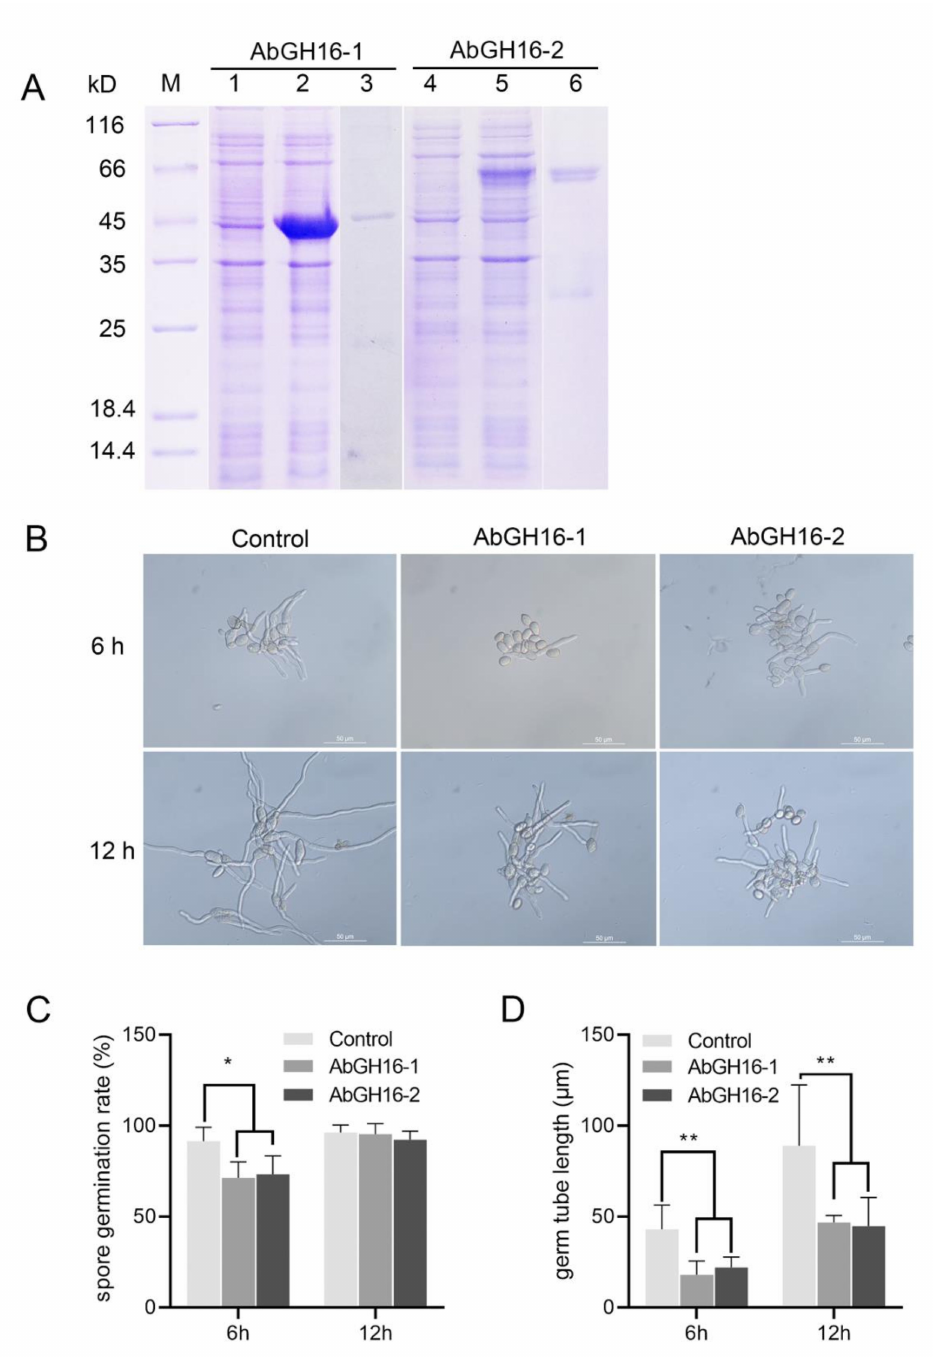
Figure 7. Antifungal activity assay of the AbGH16 recombinant protein. ( A ): The 12% SDS-PAGE analysis of AbGH16 expression in Escherichia coli. Lane M, molecular mass marker; Lane 1, 4, lysate of the non-induced E. coli cells expressing AbGH16-1 and 2; Lane 2, 5, lysate of the IPTG-induced E. coli cells expressing AbGH16-1and 2; Lane 3, 6, purified proteins of AbGH16-1 and AbGH16-2. ( B ): Germ tube elongation of Botrytis cinerea treated by AbGH16 enzymes. 10 µ g purified protein of AbGH16-1 and AbGH16-2 were mixed separately with 1 ml of a B. cinerea spore suspension (3 × 10 5 spores) in YEPD medium, and incubated at 25 ◦ C for 6 h and 12 h; the same concentration of spore suspension without addition of the proteins was used for a control (3); scale bar = 50 µ m. C-D: inhibition of the spore germination rate ( C ) and germ tube elongation ( D ) of B. cinerea . The data from two experiments with four replicates per treatment were pooled. Asterisks on the bar indicate significant differences (*, p < 0.05; **, p < 0.01) between treatments as determined by Student’s t